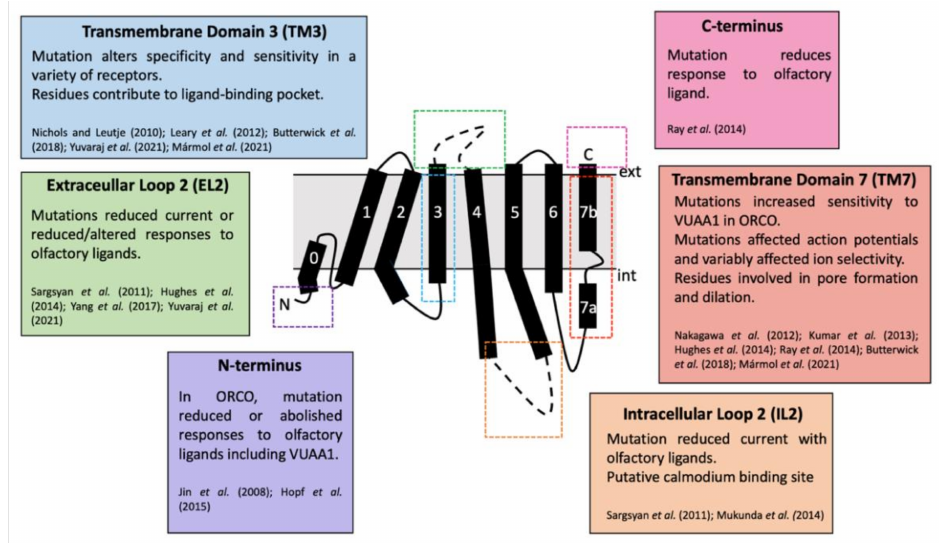
Figure 9. Topology of an ORCO subunit with key loci for activity highlighted [1,7,9,104,124,126,127, 136–142]. Not included are transmembrane domains 2,4,5 and 6, extracellular loop 3 and intracellular loop 3, which all possess additional roles in affecting sensitivity to ligands, ion selectivity and response ratios